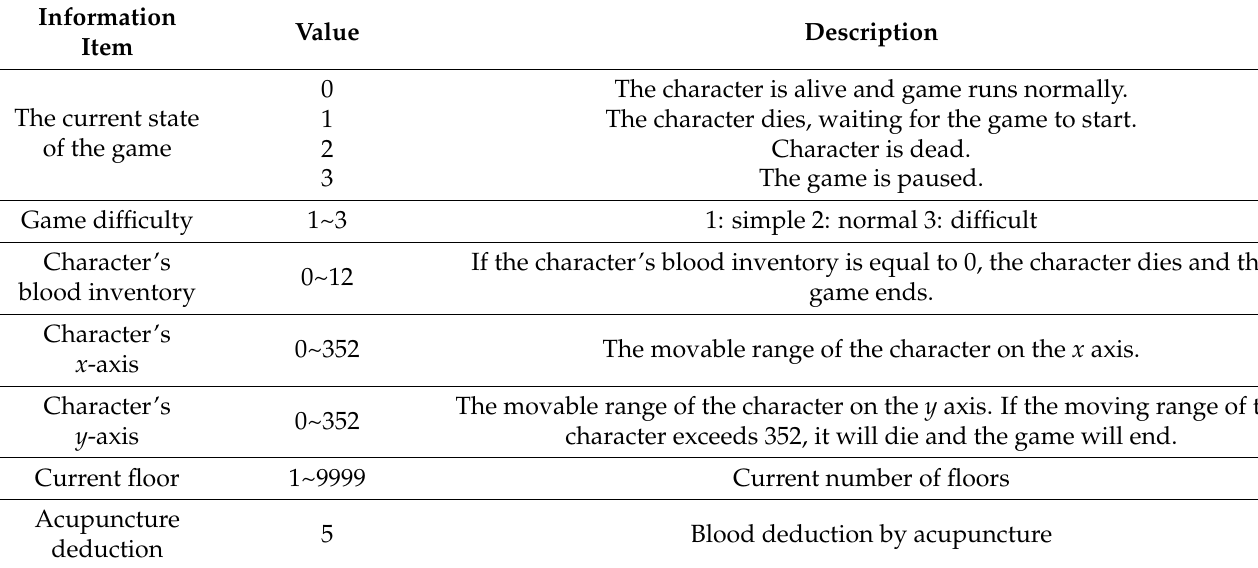
Table 3. Game internal information.